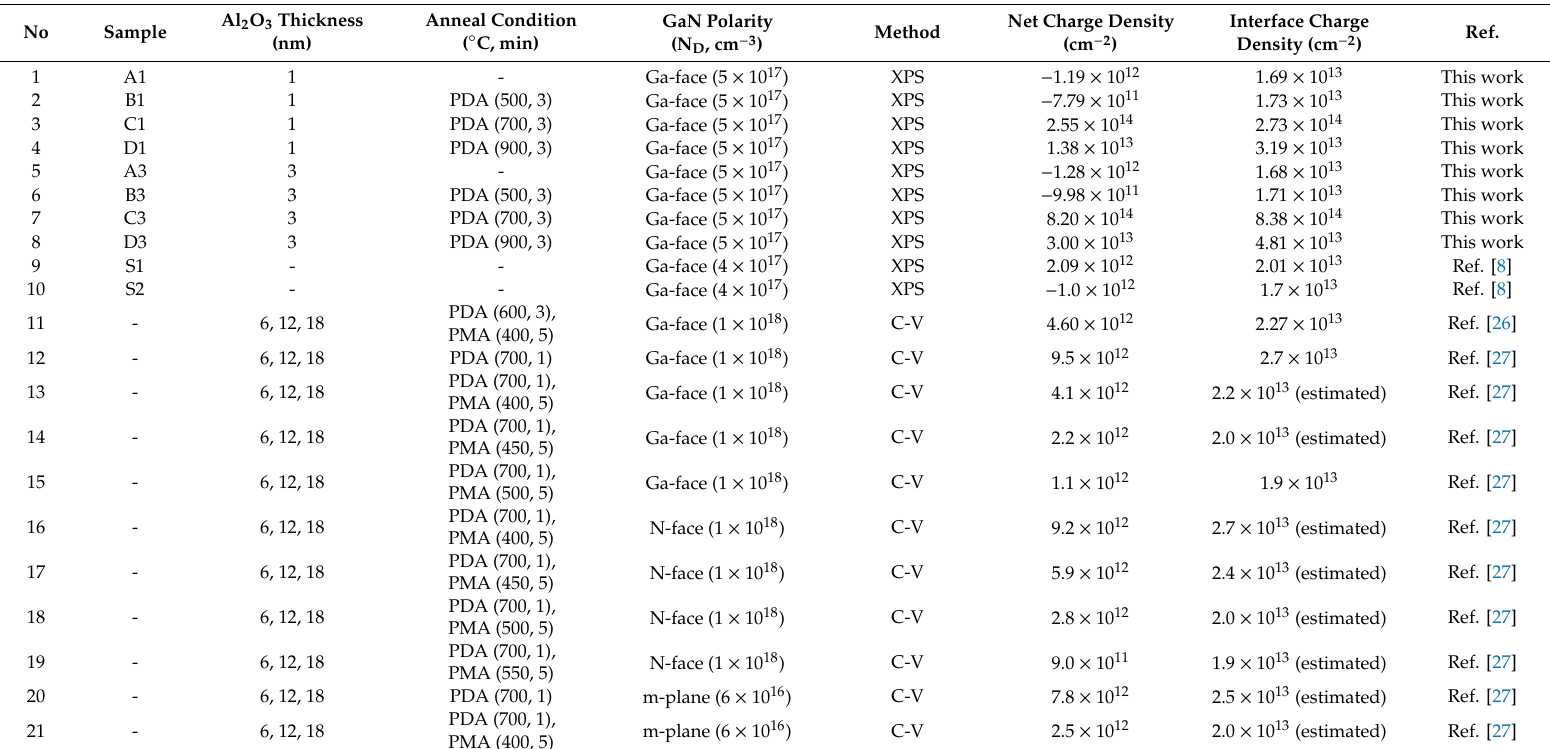
Table 2. Charge densities at Al 2 O 3 / GaN